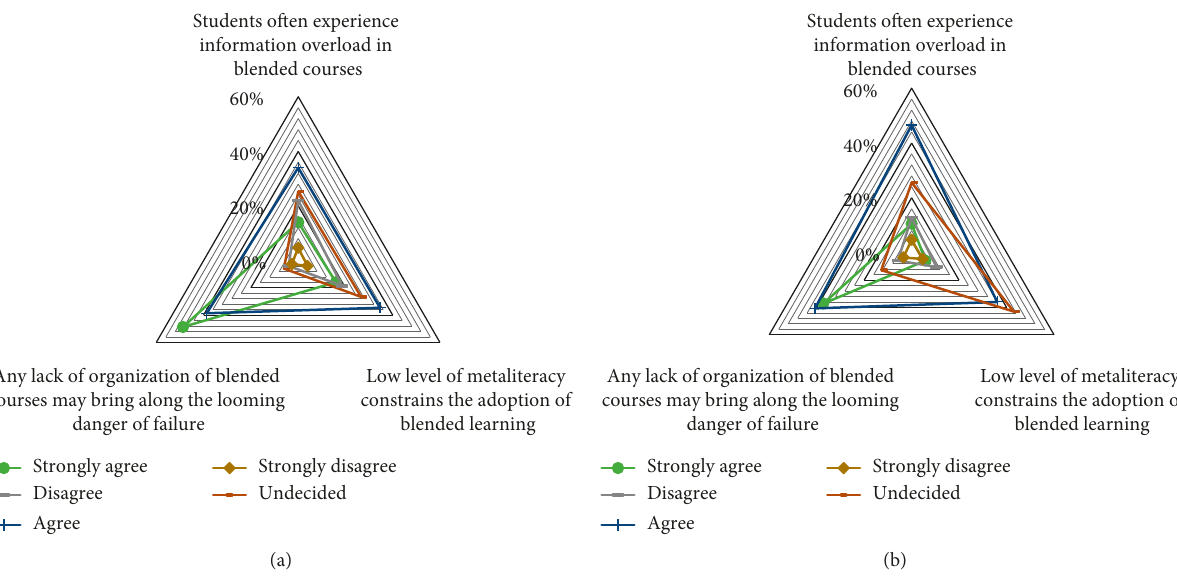
Figure 7: Challenges of integrating practices of metaliteracy with blended learning: (a) CST students’ responses and (b) ELL students’